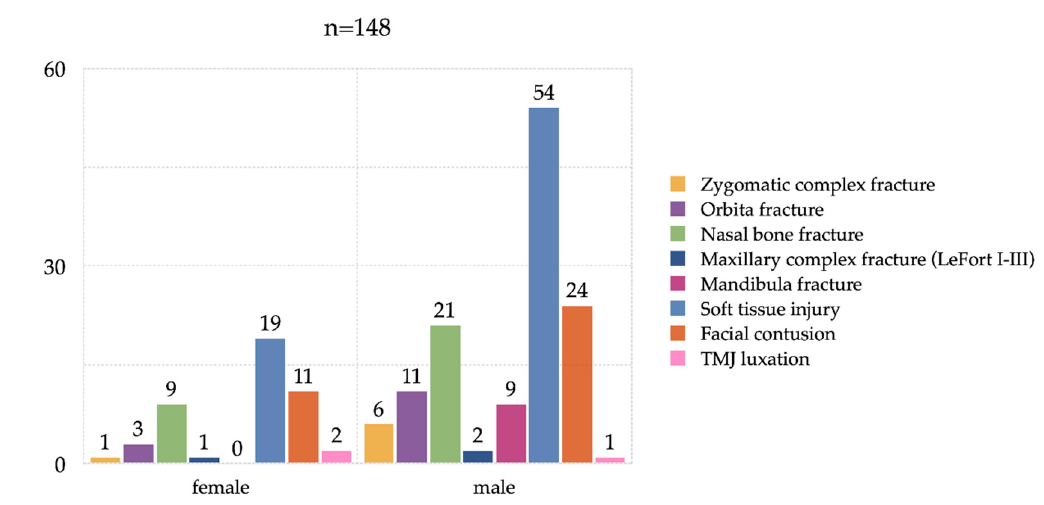
Figure 4. Distribution of CMF emergencies by gender ( n = 148).